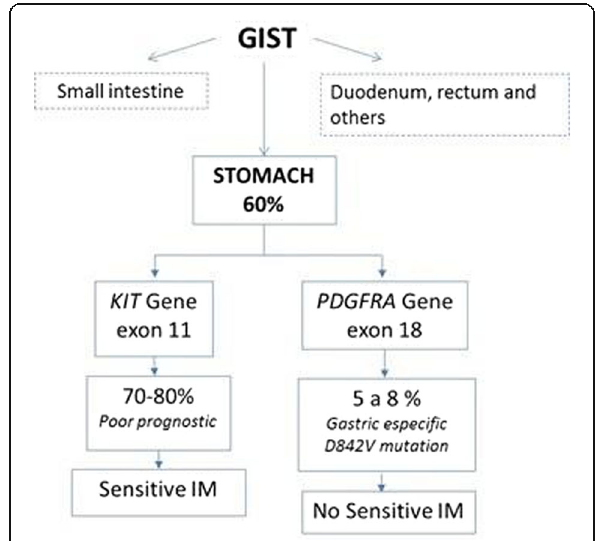
Fig. 1 Scheme summarized regarding the molecular characterization of gastric